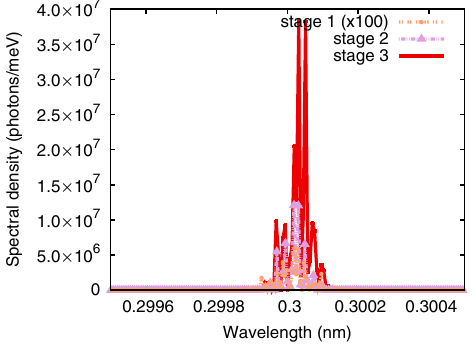
FIG. 8. Spectrum of 4 keV part of radiation for the three-stage example at the end of each stage (the first stage is scaled